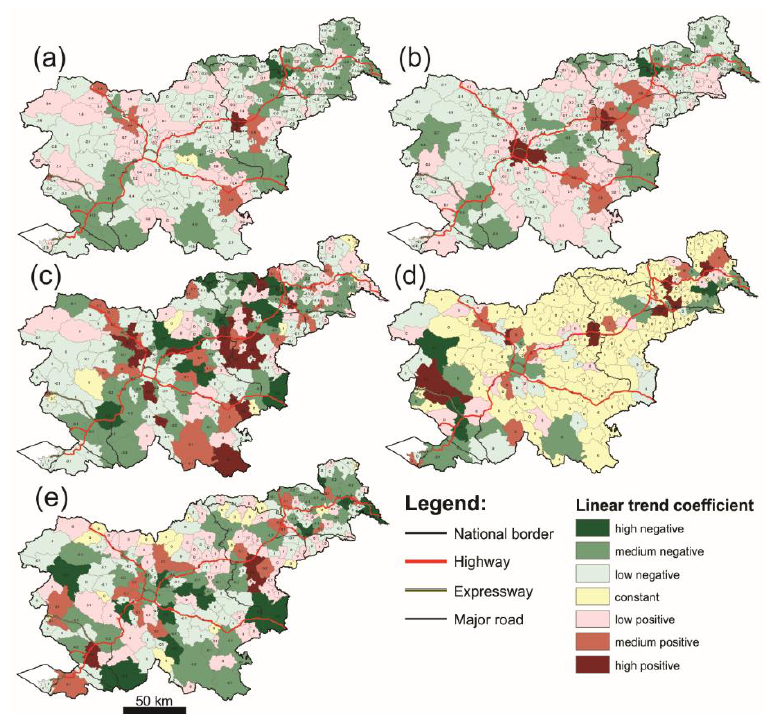
Figure 1. Spatial trends in road traffic crashes: ( a ) all crashes ( b ) rain, ( c ) snow, ( d ) wind, ( e ) fog.